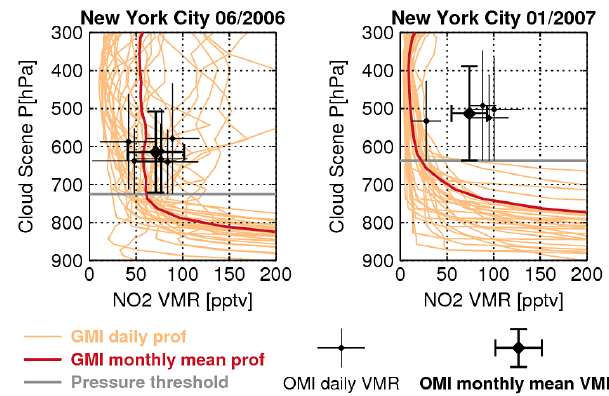
Figure A1. Example of calculating a climatological free- tropospheric NO 2 VMR for a grid box that encompasses New York City; left: May 2005; right: January 2007; lines show daily (orange) and monthly mean (red) GMI NO 2 profiles. Grey horizontal lines show the pressure threshold above which the NO 2 vertical gradient is < 0 . 33pptv hPa − 1 . Not the actual data used in the main